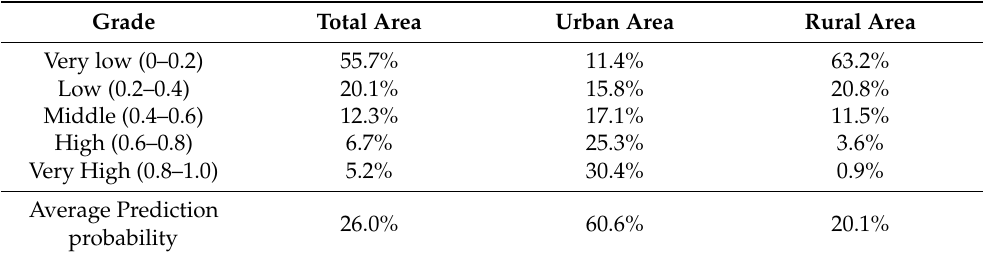
Table 5. Percentage of foodborne disease risk areas and average prediction probability based on geographically weighted logistic regression model.